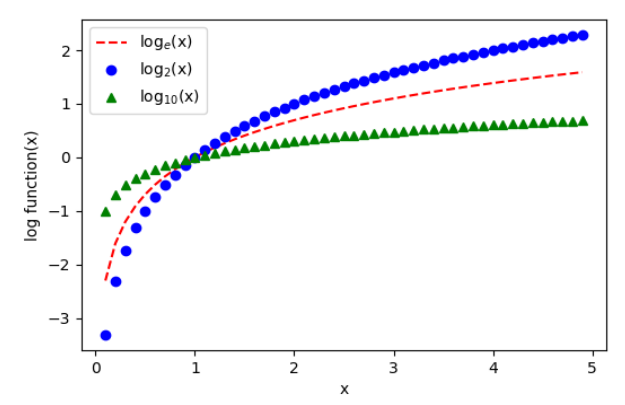
ff erence between the slope of three logarithm functions. Figure 7. Difference between the slope of three logarithm functions. Figure 7. Di